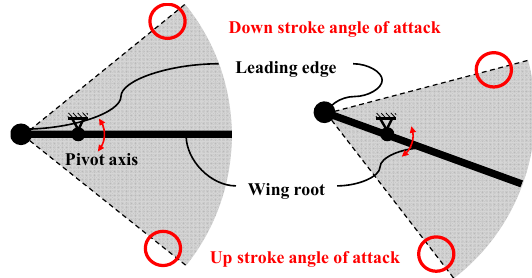
Figure 4. Range of angle of attack with respect to the wing root angle.